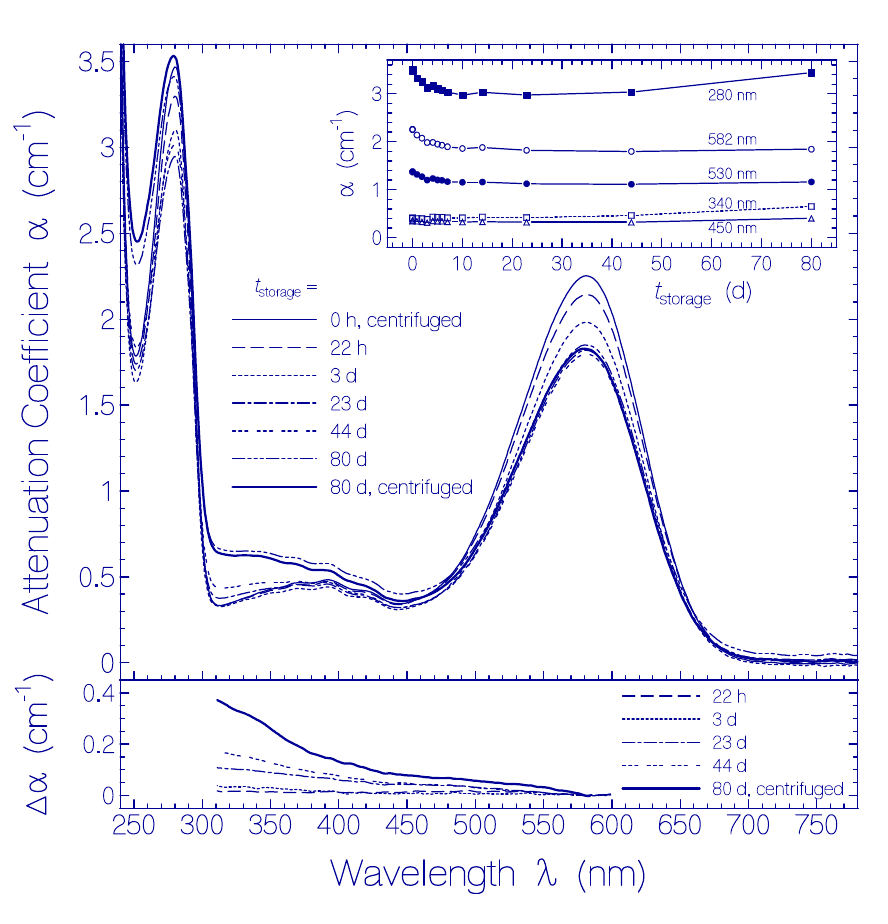
Figure 5. Temporal development of attenuation coefficient spectra α ( λ , t storage ) of QuasAr1 in pH 8 Tris buffer at 2.5 ± 0.5 °C in the dark. The storage times in the refrigerator are listed in the legend. The top inset shows attenuation coefficients at fixed wavelengths versus the storage time t storage . The bottom part displays di ff erence attenuation spectra ∆ α ( λ , t storage ) = α ( λ , t storage ) − (cid:104) (cid:105) α ( λ ,0 ) α ( 580 nm , t α ( 580 nm ,0 ) storage ) /